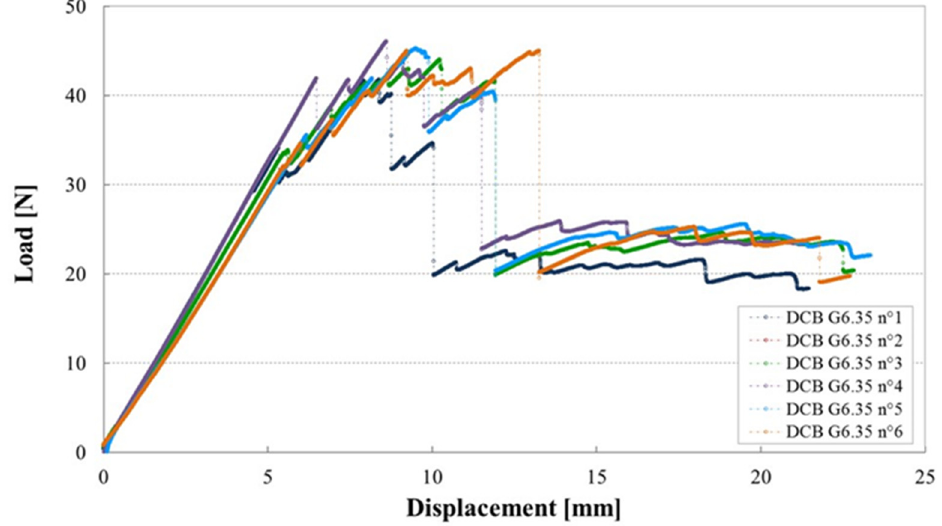
Figure 8. Load-displacement plots for the various samples containing a Gap of 6.35 mm polymerized with caul plate.